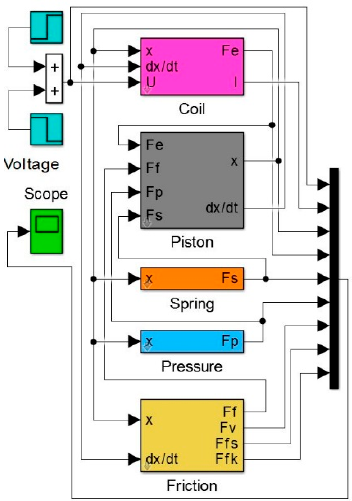
Figure 5. The block diagram in the Matlab-Simulink.